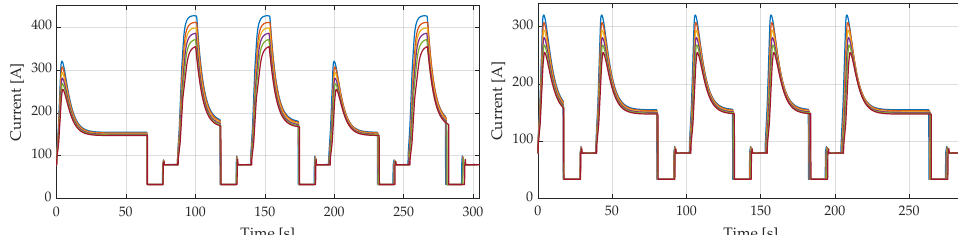
Figure 18. Current of IMC trolleybuses according to the vehicle’s weight covering the outgoing ( left ) and return ( right ) journeys of line 14. The weights start at 30 t (upper blue line) and decrease to 20 t (bottom red line) with 2 t steps.